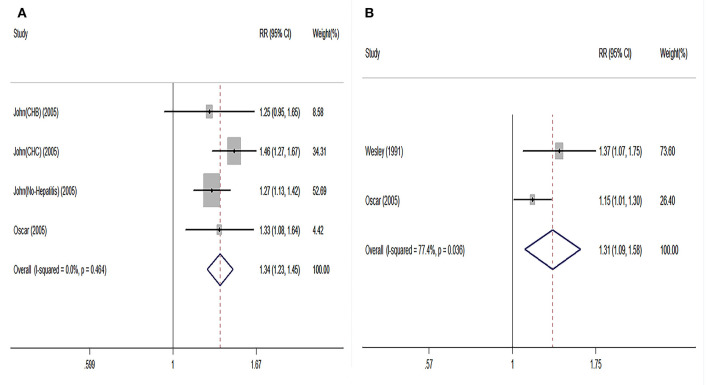
Pooled results on comparison in LT cases categorized by grafts from adults and adolescents. (A) Pooled RR on graft failure between adult and adolescent groups. (B) Pooled RR on patient death between adult and adolescent groups. Adults were defined as the donors aged elder than 18 years; adolescents were defined as the donors aged younger than 18 years. RR, relative risk; LT, liver transplantation.